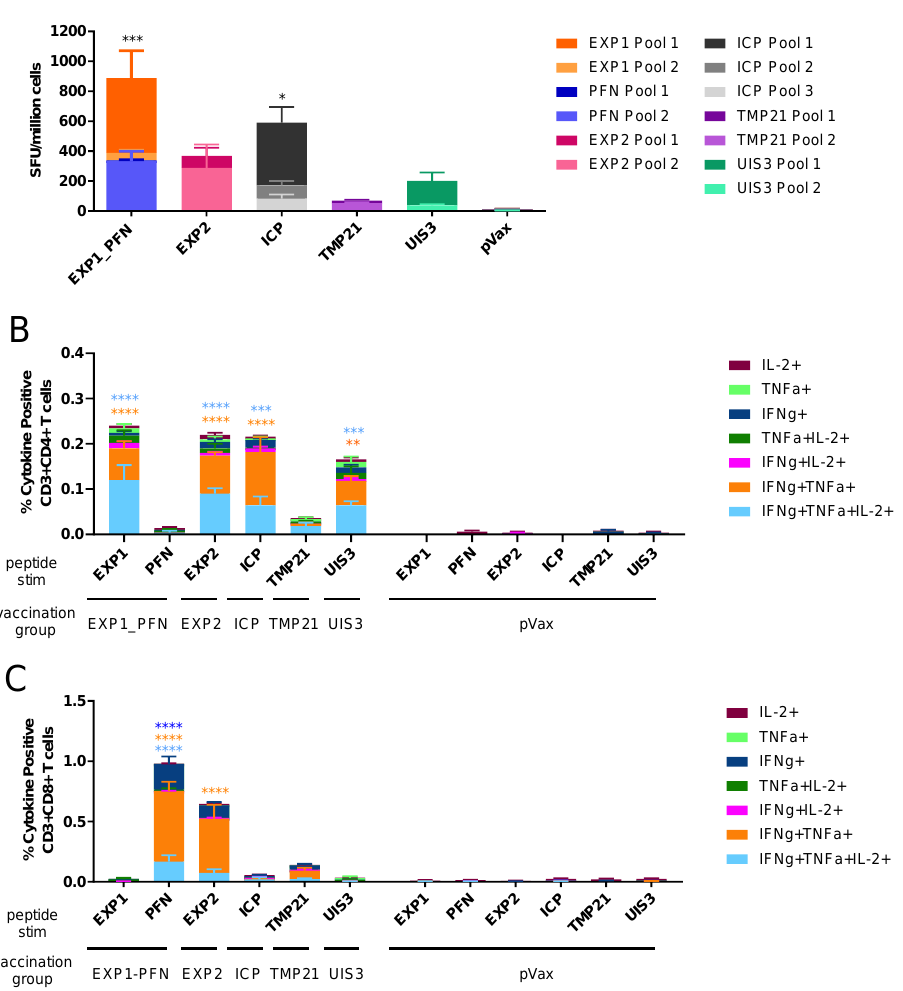
Figure 2. Functional profile of cellular immune responses elicited by individual Py DNA vaccines in mice. Mice were immunized 4 times at 3-week intervals with the indicated constructs. Splenocytes were collected 1 week after the final immunization. ( A ) The Py antigen-specific cellular immune response measured by IFN γ ELISPOT of splenocytes 1 week after final immunization with the indicated vaccine. Cells were stimulated for 18 h with peptide pools encompassing the entire protein.